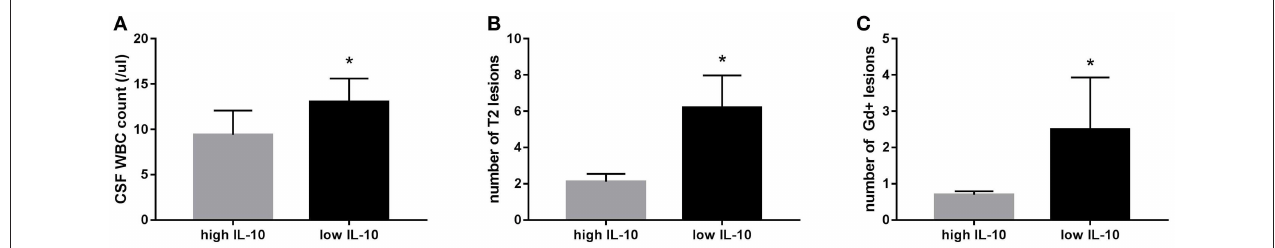
FIGURE 4 | Positive correlations between serum IL-10 levels and clinical and laboratory data. Compared to the high IL-10 group, we found a significantly higher cerebrospinal fluid (CSF) white blood cells (WBC) count ( p = 0.035) (A) , number of T2 lesions ( p = 0.036) (B) , and number of gadolinium-enhancing (Gd + ) lesions in baseline MRI ( p = 0.049) (C) in the low IL-10 group. * p < 0.05 represent statistical significance in the Mann-Whitney U -test.